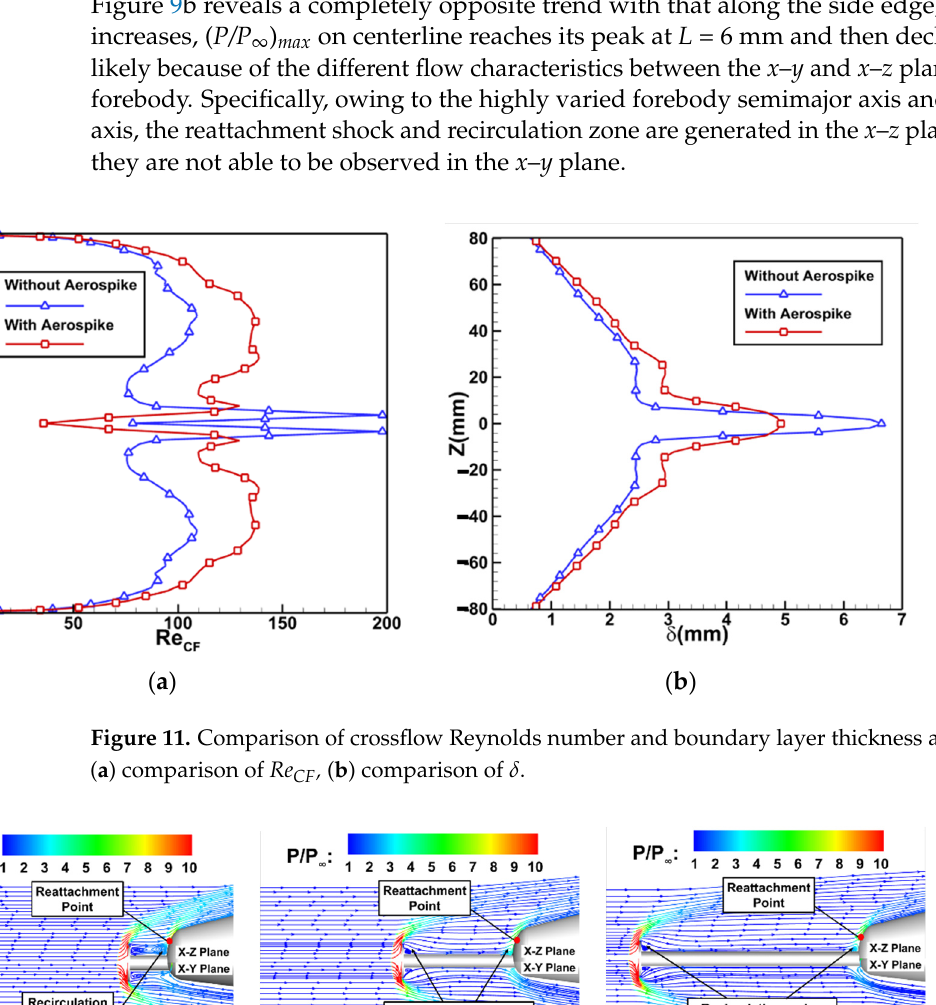
Figure 12. Comparison of P/P ∞ in the leading edge. ( a ) L = 2 mm, ( b ) L = 6 mm, ( c ) L = 12 mm.